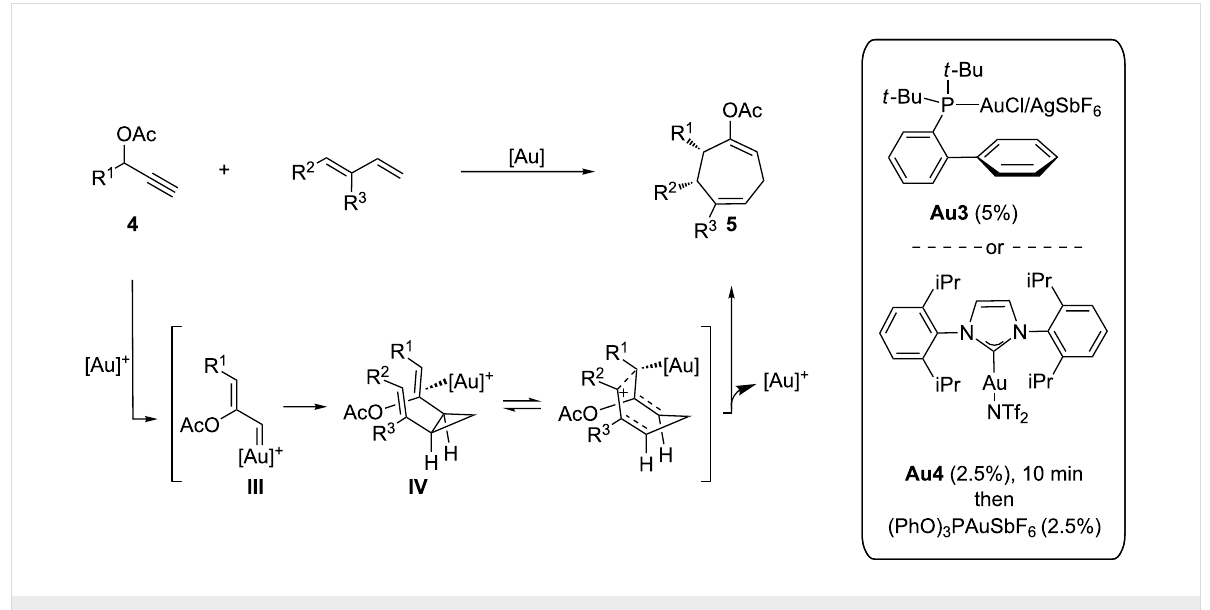
Scheme 3: Gold-catalyzed cyclohepta-annulation cascade.